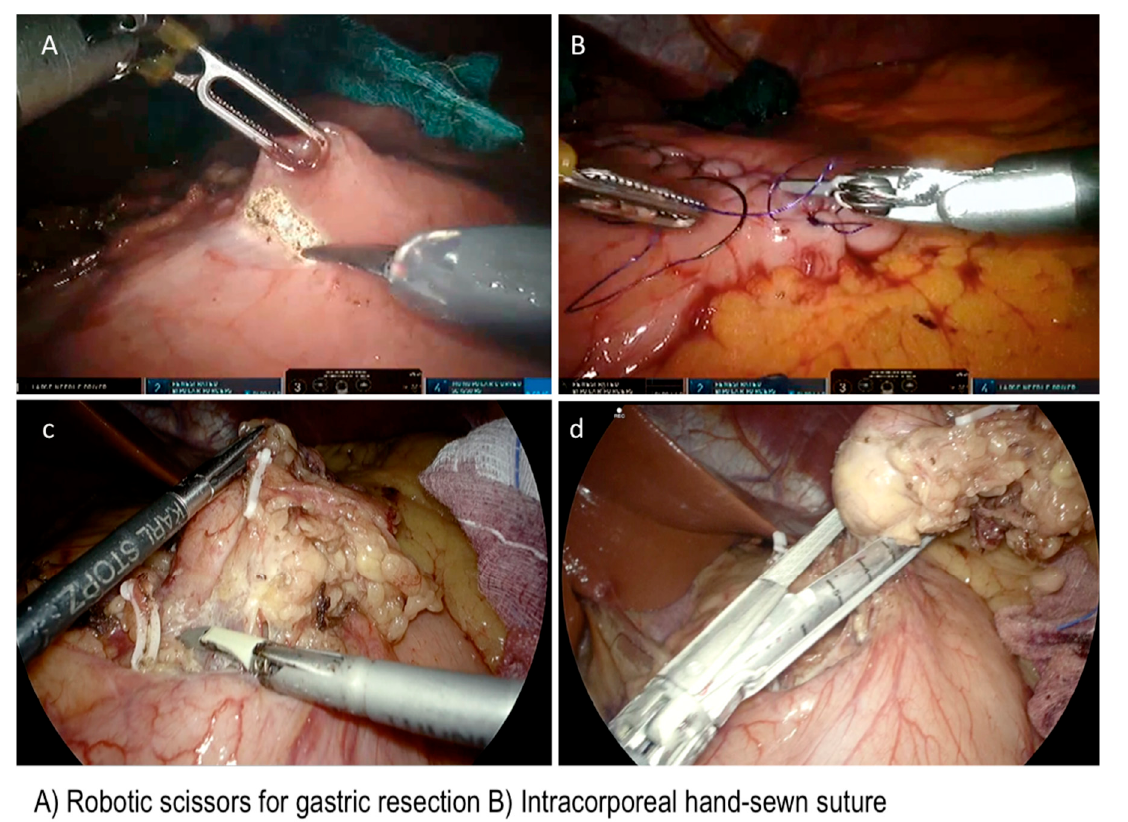
Figure 6. Endoscopic view of luminal lesion and robotic approach.